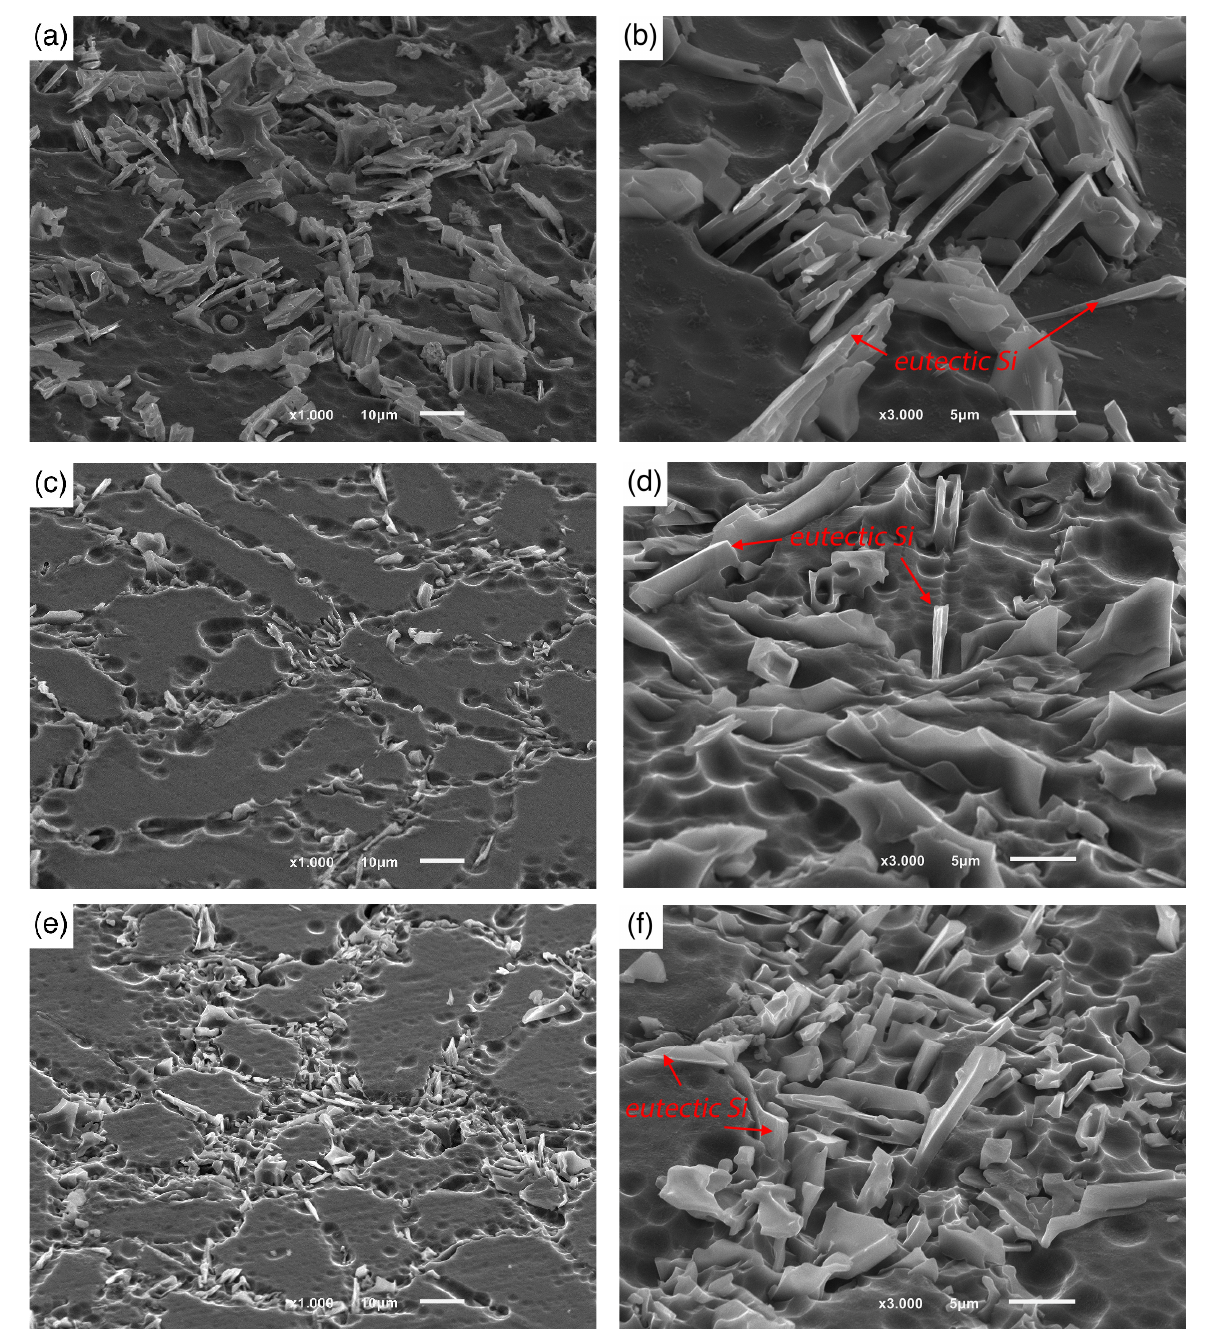
Figure 4. SEM micrographs (BSE mode) of the morphology of the fragmented eutectic silicon of ( a ) and ( b ) sample A; ( c ) and ( d ) sample B; ( e ) and ( f ) sample C. (magnification ×1000 and ×3000). sample A; ( c , d ) sample B; ( e , f ) sample C. (magnification × 1000 and ×